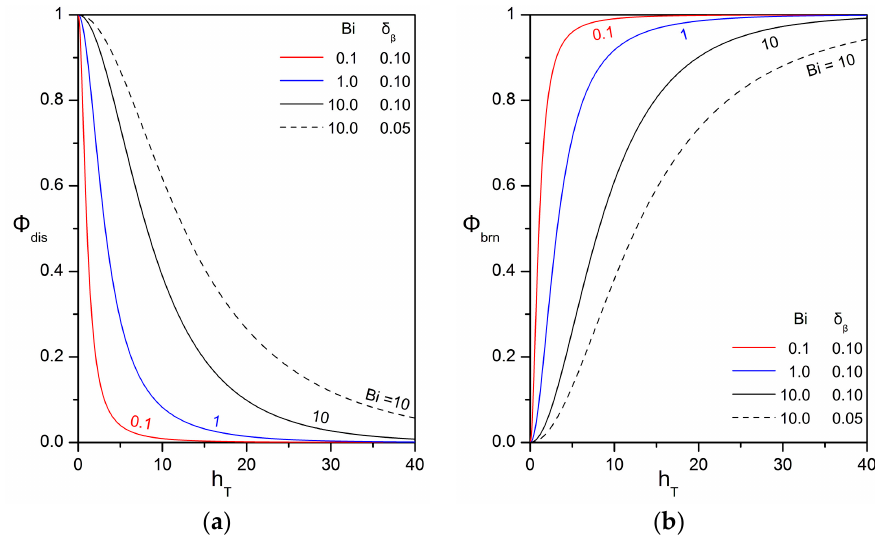
Figure 4. Impact of the Thiele and Biot numbers on: ( a ) the mass fraction of dissolved oil that is released into the aqueous phase; ( b ) the mass fraction of dissolved oil that is biodegraded within the biofilm. The values of the other parameters are: Λ A β = 1; H A , υ / β =